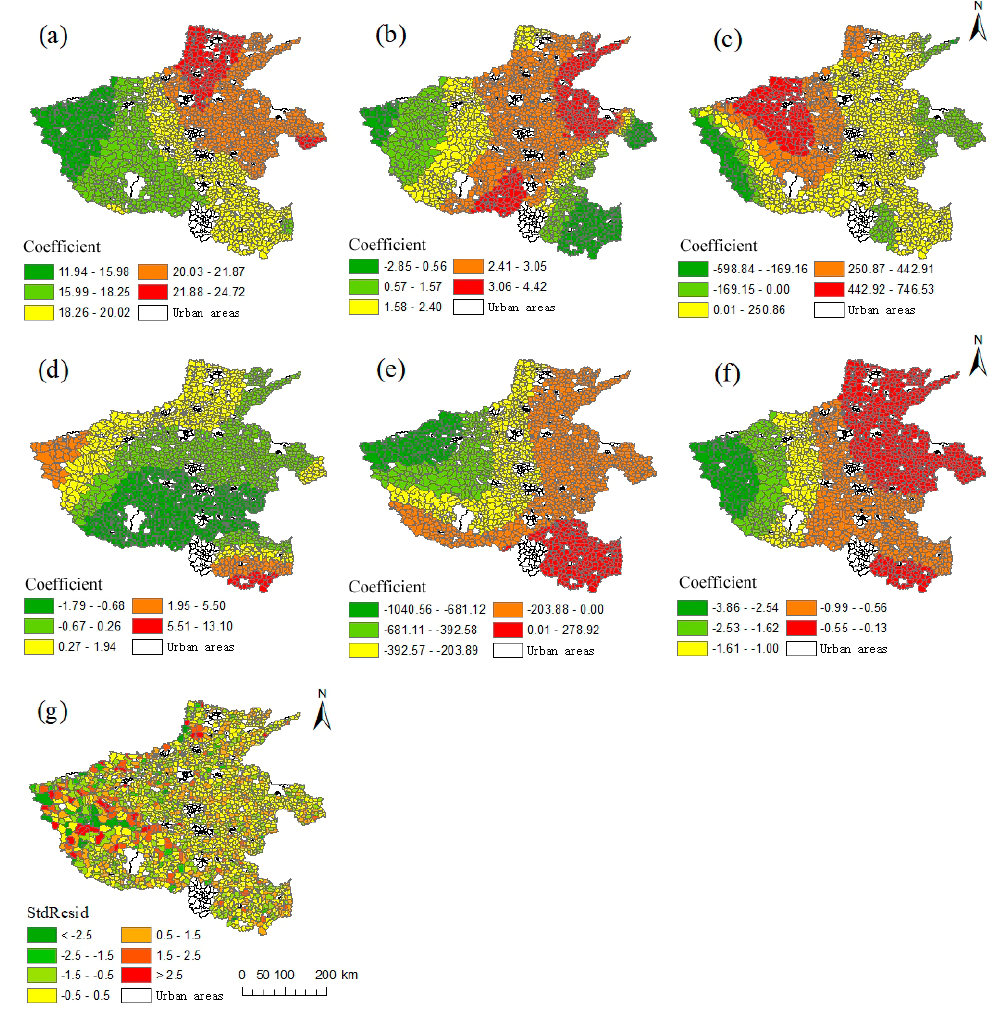
Figure 7. Spatial pattern of both regression coefficient and standardized residual of the GWR Model: ( a ) regression coefficient of the area; ( b ) regression coefficient of the elevation; ( c ) regression coefficient of the residential area density; ( d ) regression coefficient of the per capita industrial output value; ( e ) regression coefficient of the road network density; ( f ) regression coefficient of the population density; ( g ) standardized residuals.